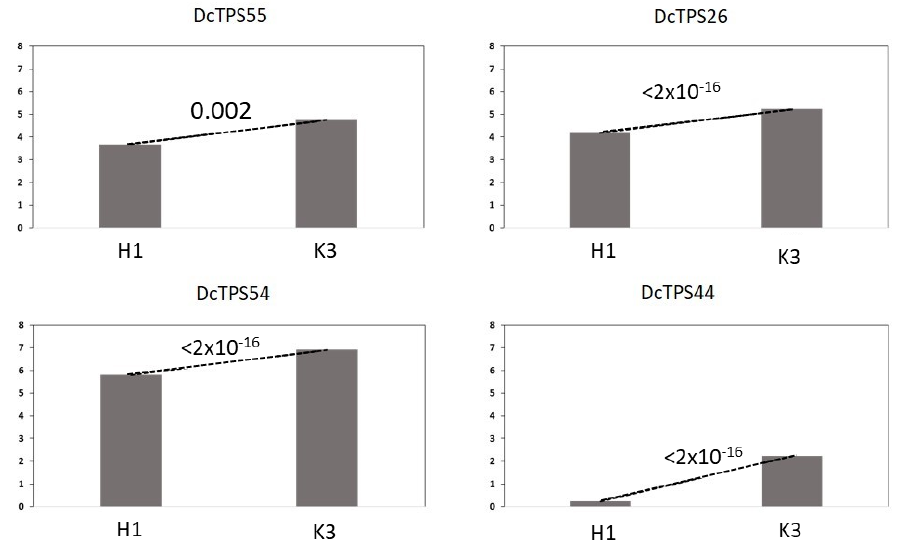
Figure 3. Relative expression of TPS genes located in the mQTL-rQTL co-localization regions on chromosomes 4 and 8 in H1 (susceptible) and K3 (resistant) genotypes. The number above the dotted line indicates significance of the difference ( p -value).